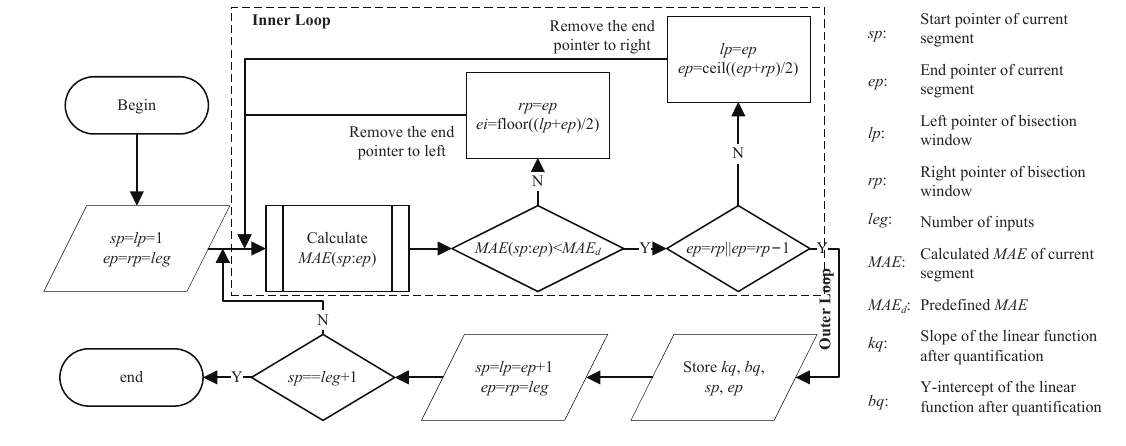
Figure 3. Procedure of the segmentor in